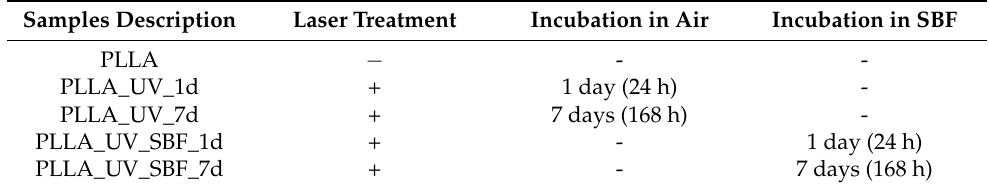
Table 3. Samples